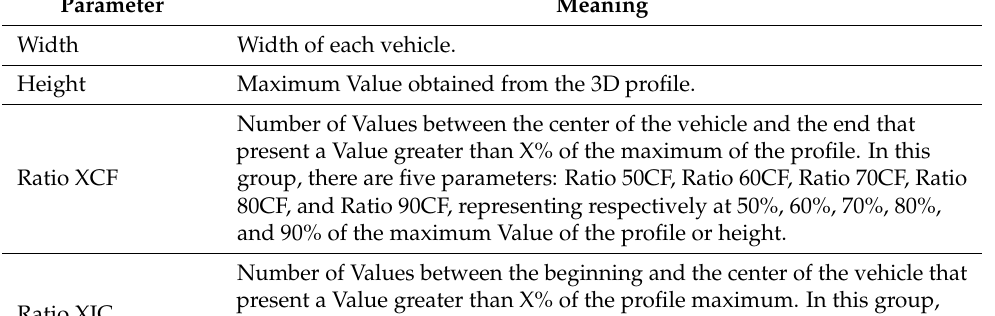
Table 4. Predictive